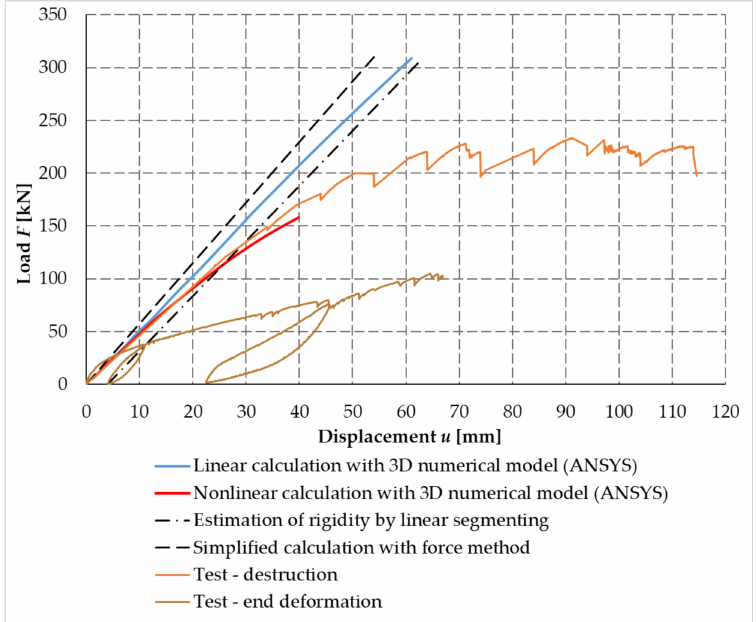
Figure 22. Load–displacement diagram with experiment sample no. 1 and calculations.